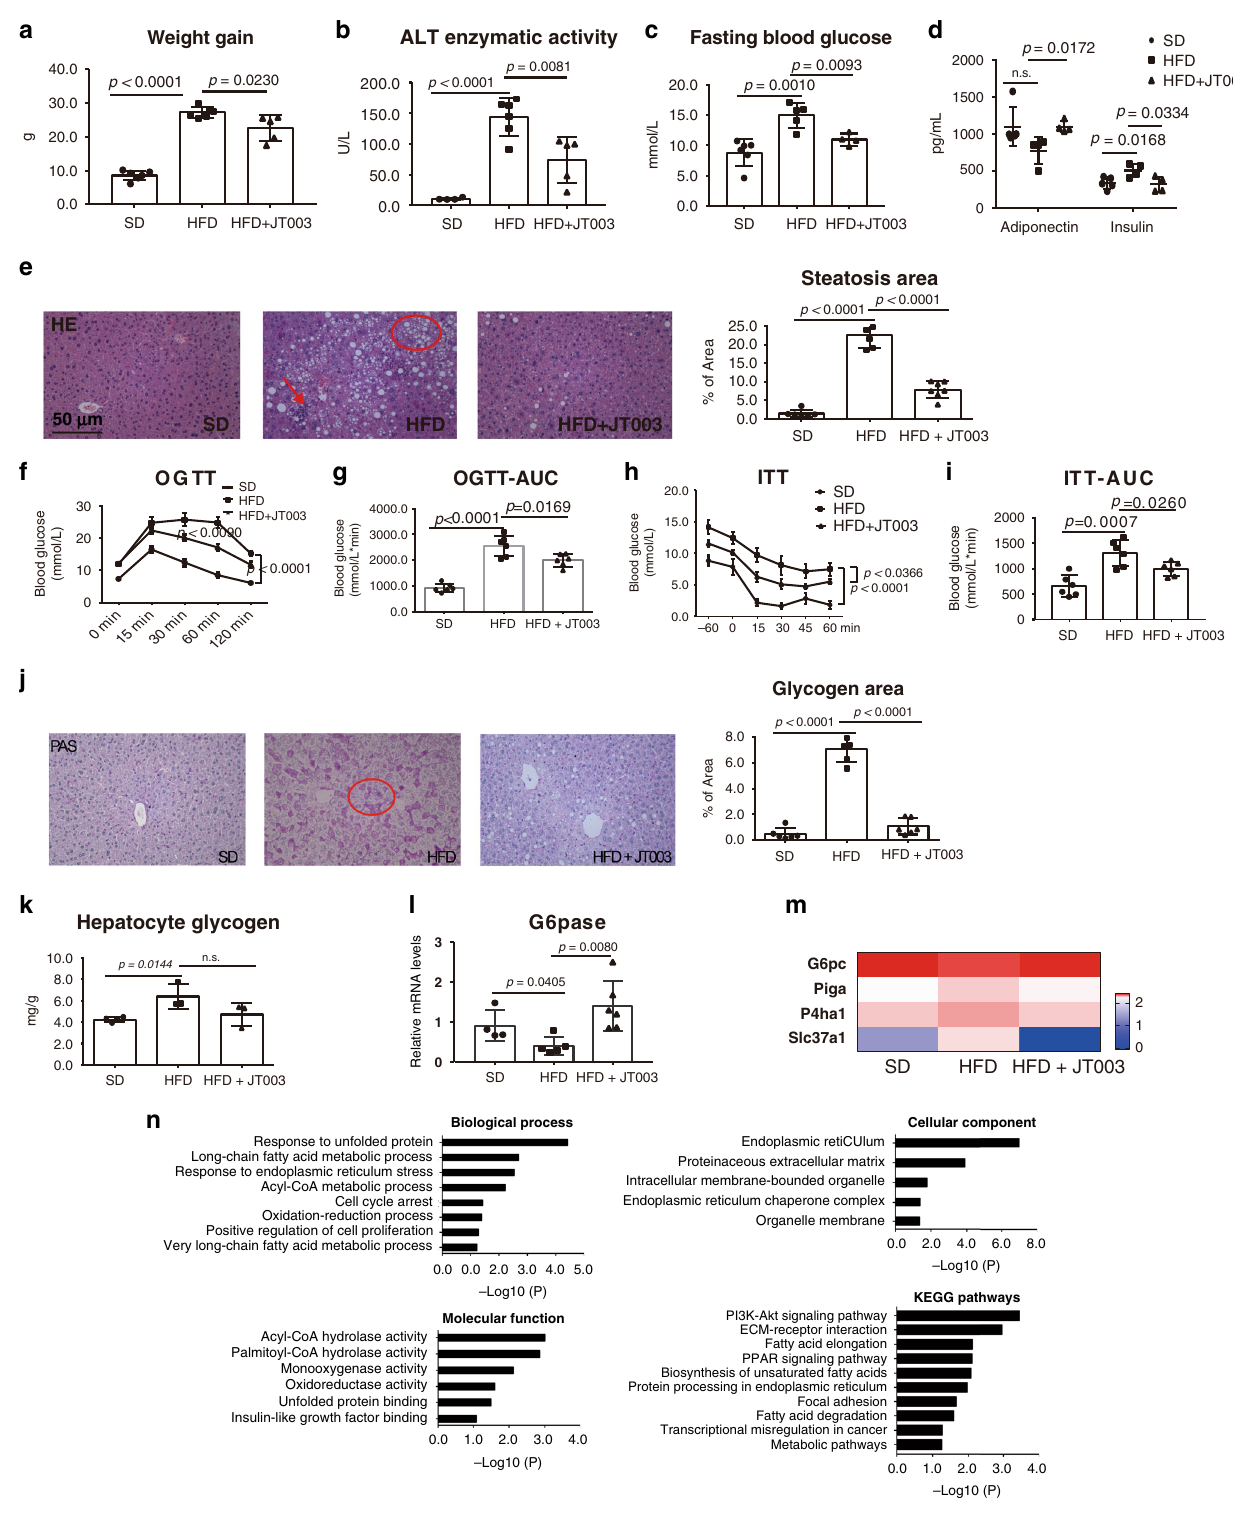
(Fig. 4f, g). These results showed that ER-mitochondrial axis in NASH mice indeed contributed to the recovery of NASH process. JT003 inhibits the progress of CCl 4 -induced liver fi brosis . Lipid metabolism disorders change the gene expression in liver cells, the injured steatotic hepatocytes induce fi brosis genesis 41 . Then,